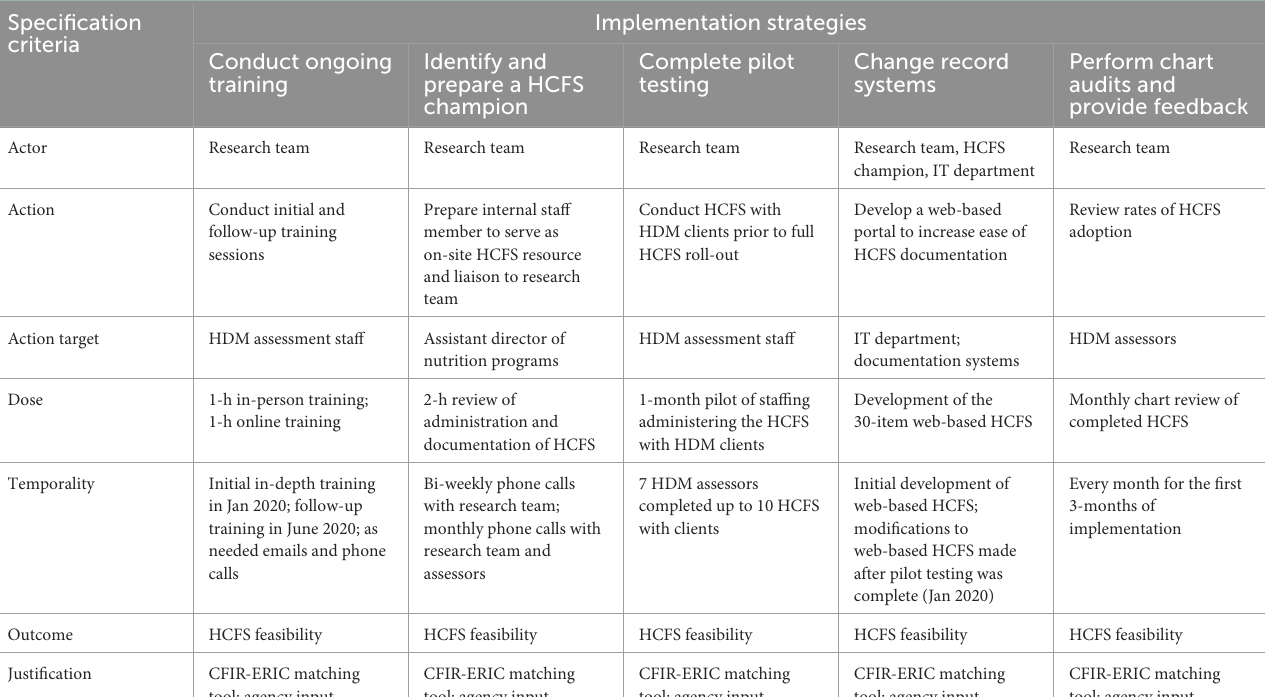
TABLE 1 Specification of strategies to promote HCFS